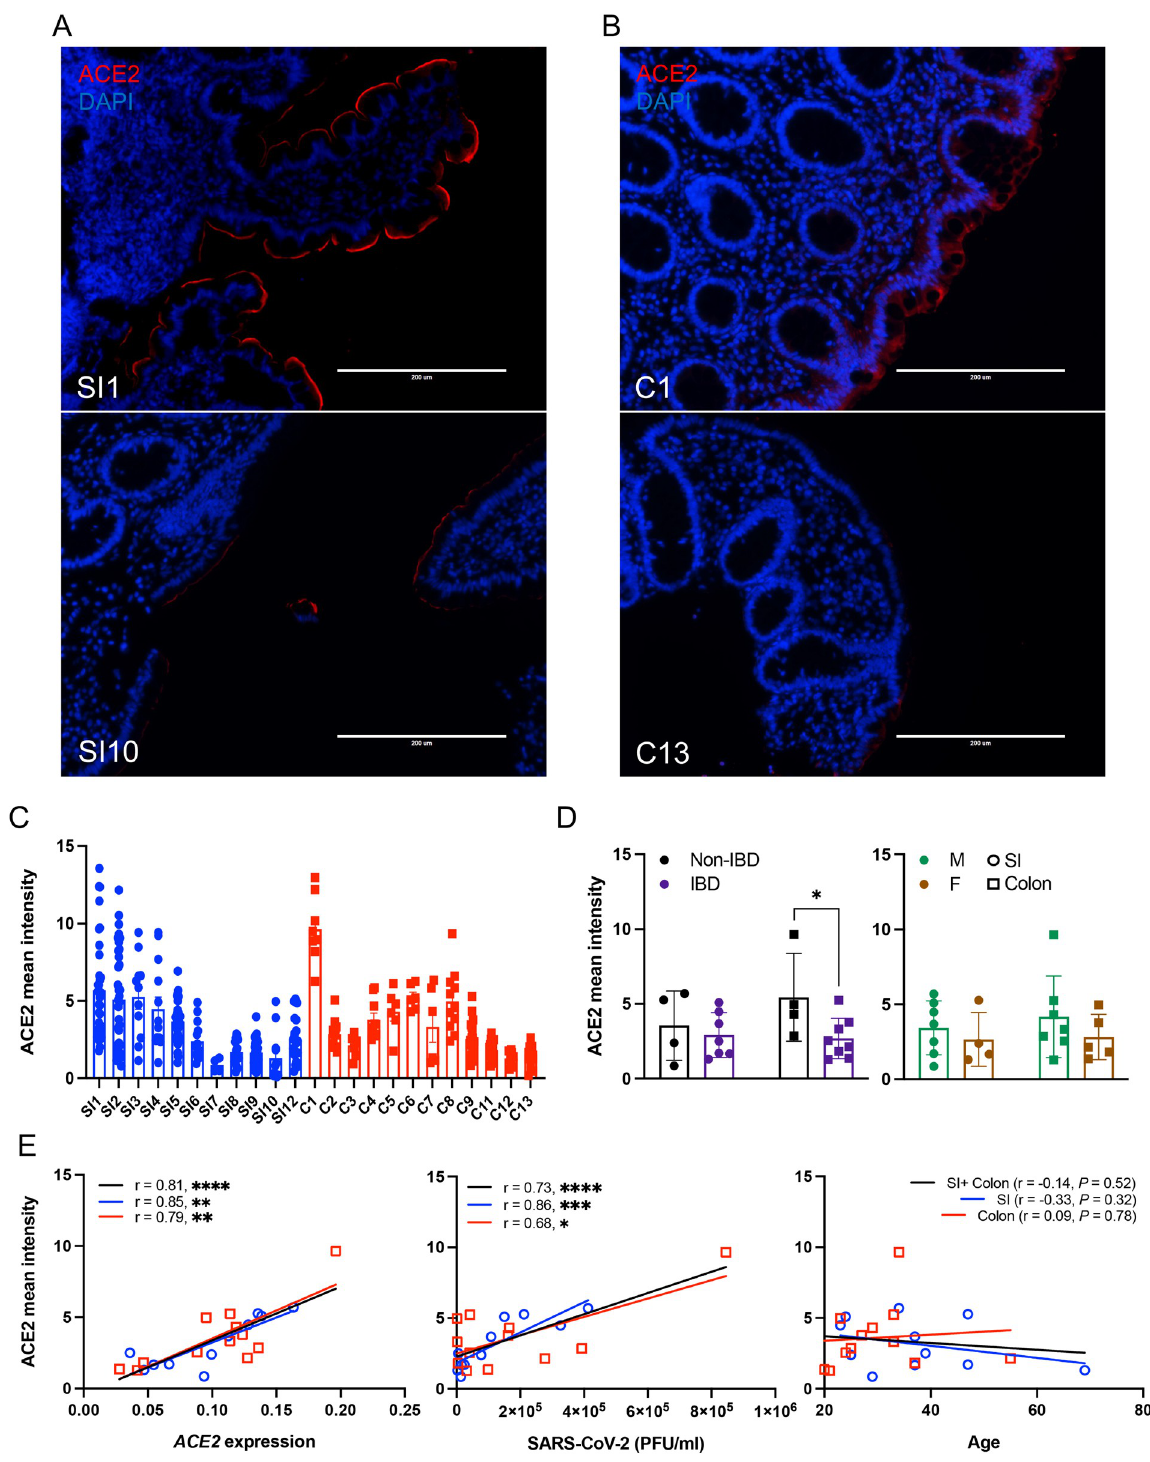
Fig 3. Differential ACE2 expression observed in individual intestinal organoid lines are conserved in primary tissue from the same donor. (A and B) Representative ACE2 staining images in primary tissues of terminal ileum (A) and ascending colon (B) from which SI1, SI10, C1, and C13 organoids were established. (C) Mean intensity of ACE2 per area in each field of view from the primary tissues from which small intestinal and colonic organoids were established. (D) Mean intensity of ACE2 by disease (left) or sex (right). (E) Correlation of ACE2 mean intensity with ACE2 expressions (left) and SARS-CoV-2 PFU (middle) among monolayers or donor age (right). Data points in C are the field of views, and